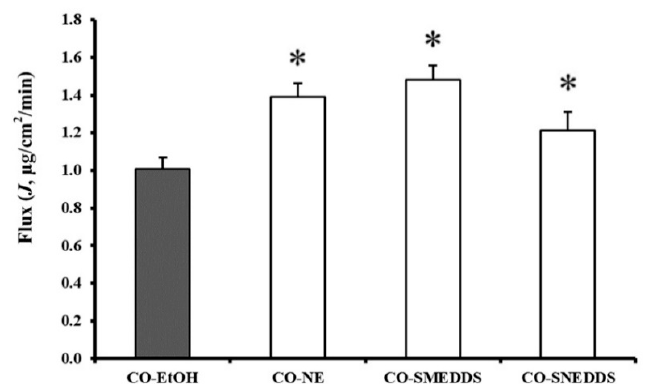
Figure 5. The penetration fluxes of eugenol in the different CO formulations. Significant differences ( p < 0.05) to CO-EtOH are indicated by an asterisk (*). Data are presented as means ± SD ( n = 3).